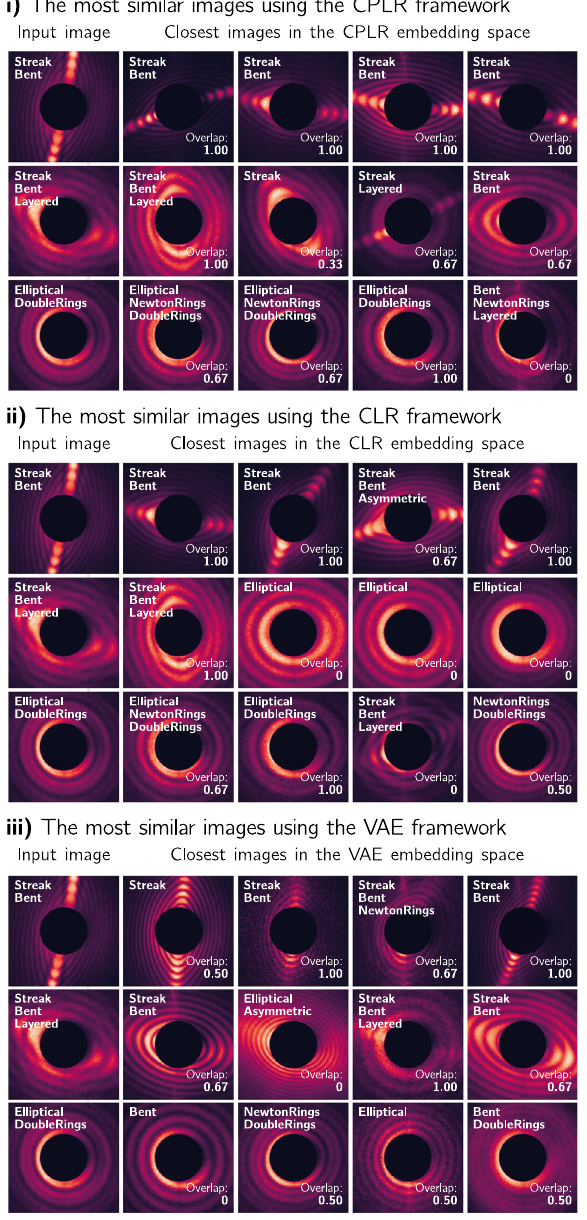
Fig. 3 Qualitative results on the helium nanodroplets dataset. In i) to iii) the column Input image shows three randomly chosen images — from a pre-de fi ned class combination. Next to the input images are the four closest diffraction images according to calculated pairwise distances for the CPLR, CLR, and VAE method using the metric given in Table 1. Every image is augmented in the top left corner by the class names given in the ground truth data and — for all images but the input image — the overlap score with its corresponding input